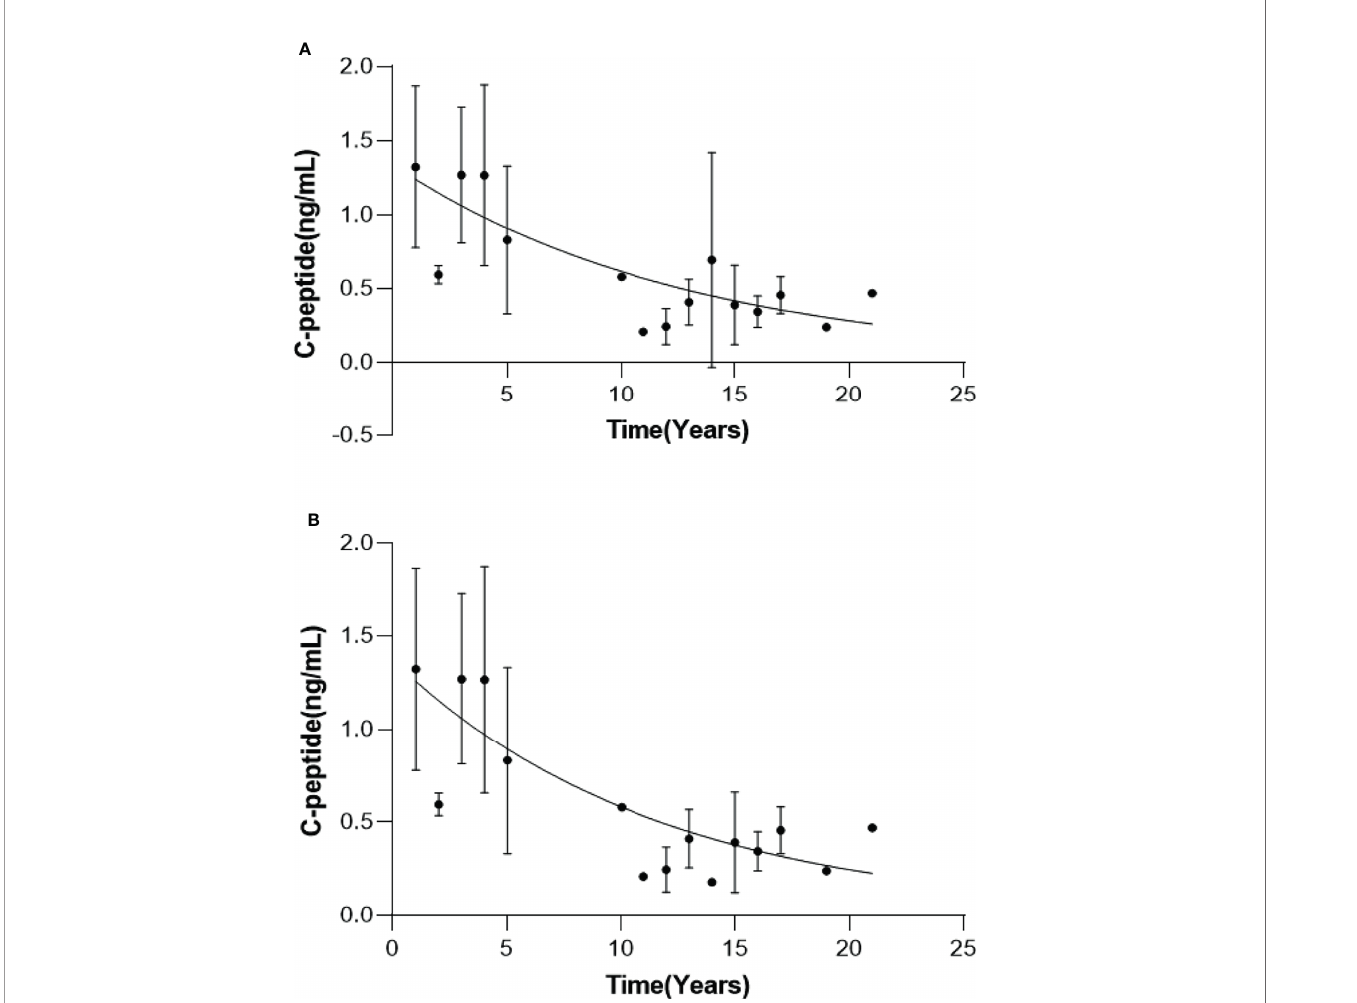
FIGURE 2 | Changes in fasting C-peptide with the duration of disease in MD patients. Curves of fasting C-peptide with disease duration for all MD patients (A) and MD patients except P#4 (B)